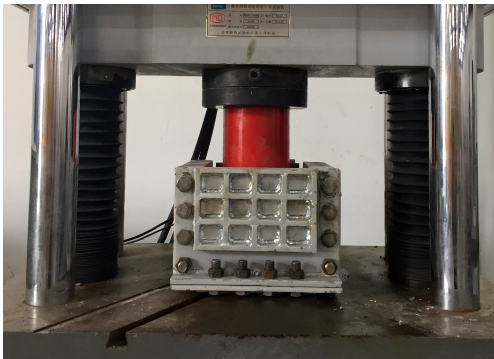
Figure 6. Axial loading of a sample.